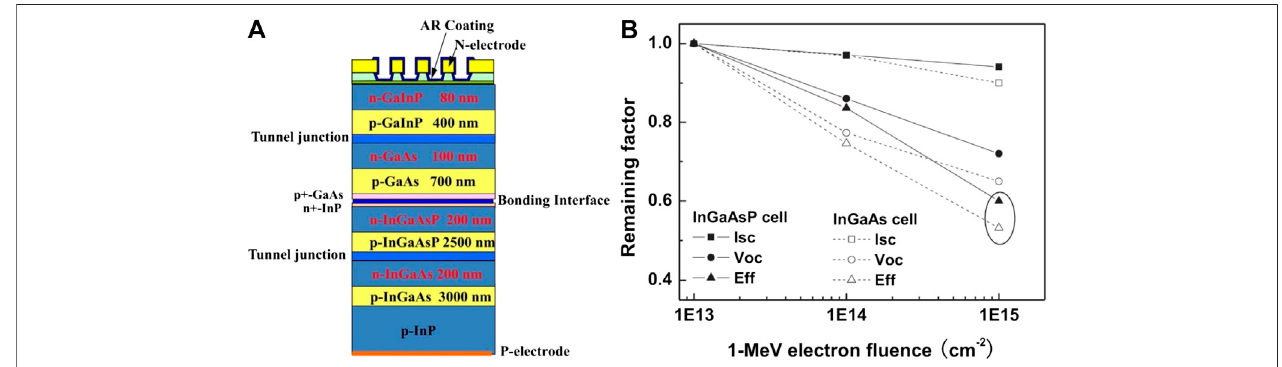
FIGURE 2 | (A) Schematic structure of wafer-bonded GaInP/GaAs//InGaAsP/InGaAs four junction solar cell; (B) the remaining factors of InGaAs and InGaAsP single-junction solar cells as a function of 1 MeV electron irradiation fl uence (B) [71].